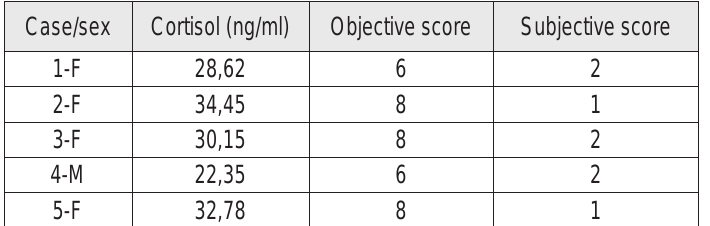
Table 2. Comparison of obtained basal plasma cortisol value to normal mean value (55 ng/ml)